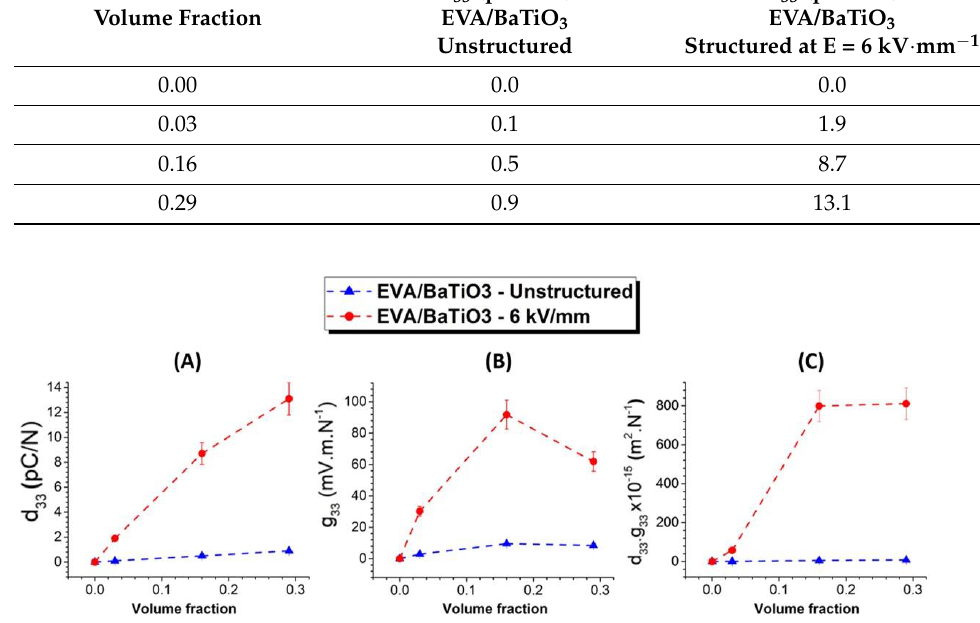
Figure 8. ( A ) Measured piezoelectric charge coefficient (d 33 ), ( B ) piezoelectric voltage coefficient, ( C ) transduction coefficient, as a function of the filler content for both structured and unstructured composites.